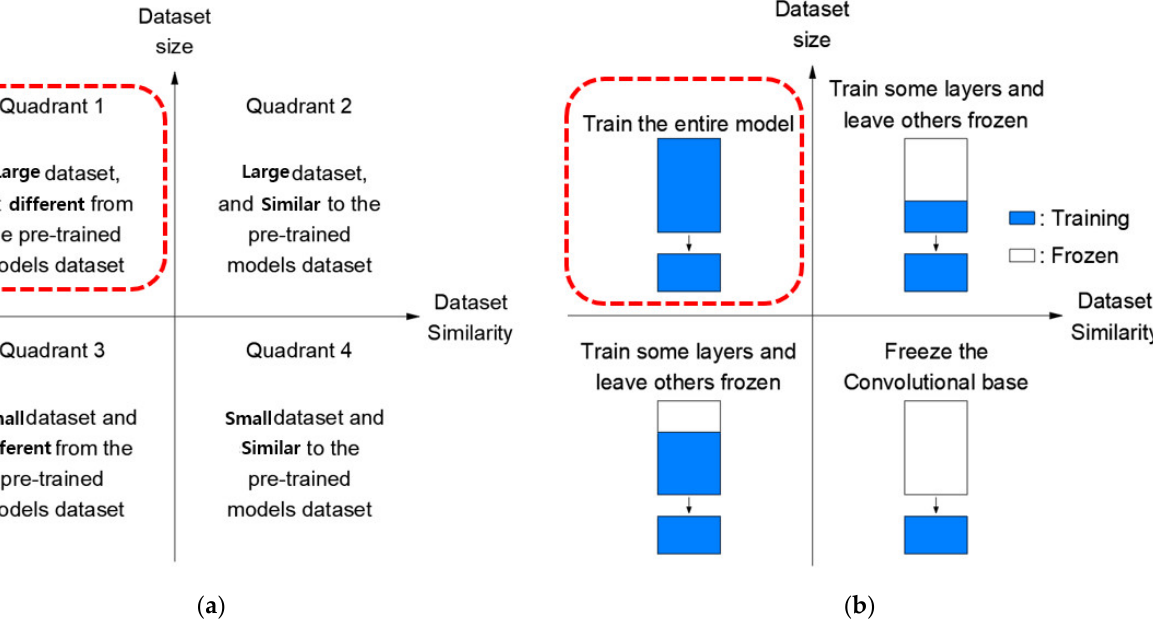
Figure 2. Fine-tuning method should be listed as: ( a ) condition of dataset size and similarities; ( b ) options of fine-tuning.